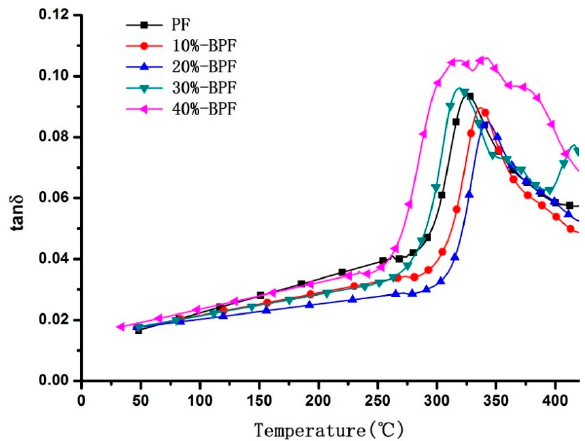
Figure 2. tan δ curves of various BPF resins.